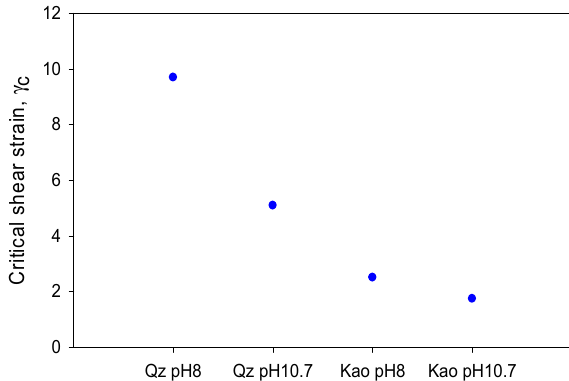
Figure 8. Critical shear strain for quartz and kaolin slurries at different pH levels.